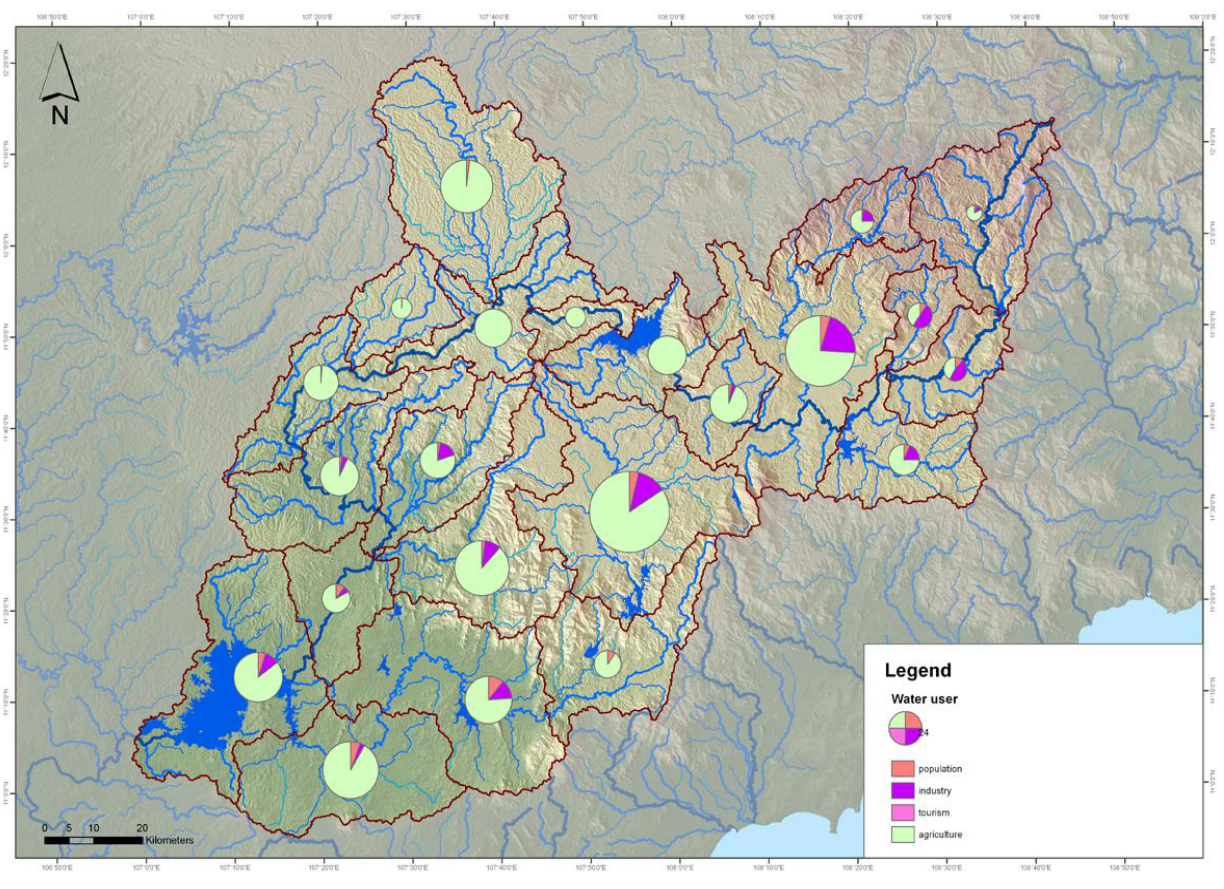
Figure 7. Amount of water demand for the different sectors during dry season (excluding ecowater